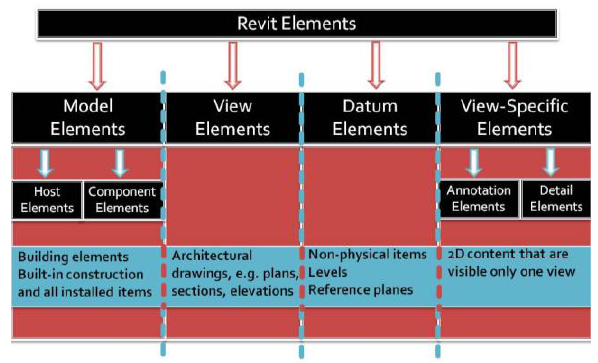
Figure 5. Elements and Families in Autodesk Revit (Source: